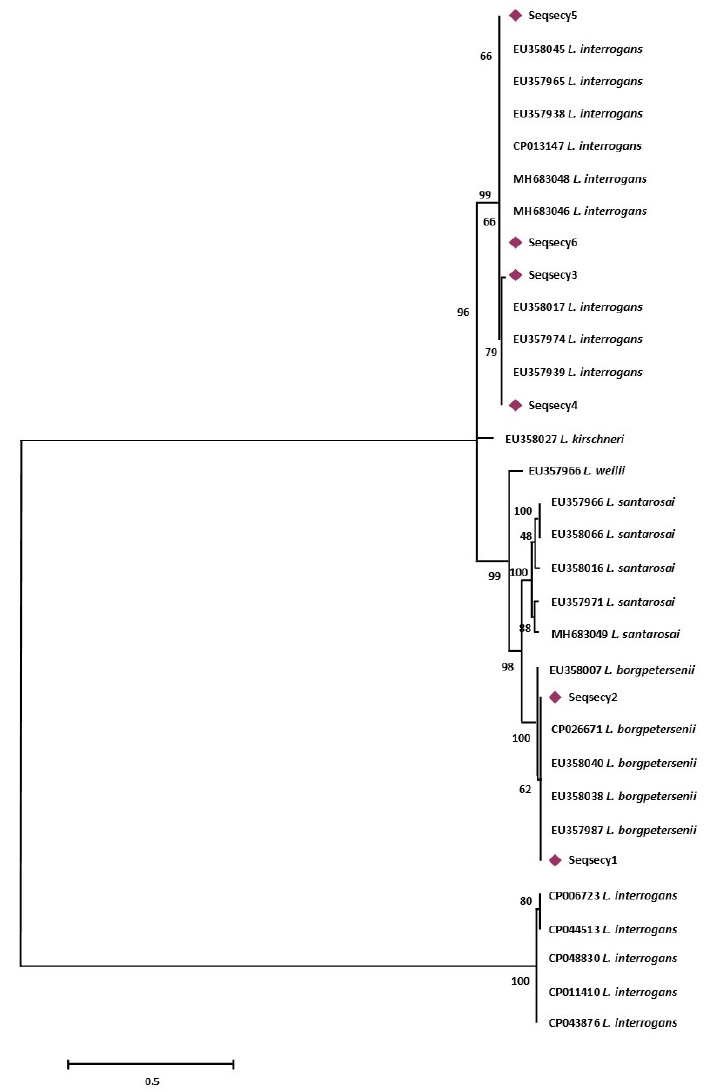
Figure 2. Maximum Likelihood method based on the Tamura 3-parameter model. The analysis involved 32 nucleotide sequences. All positions containing gaps and missing data were eliminated. There were a total of 486 positions in the final dataset. Statistical support for internal branches of tree was evaluated by bootstrapping with 1000 reiterations.